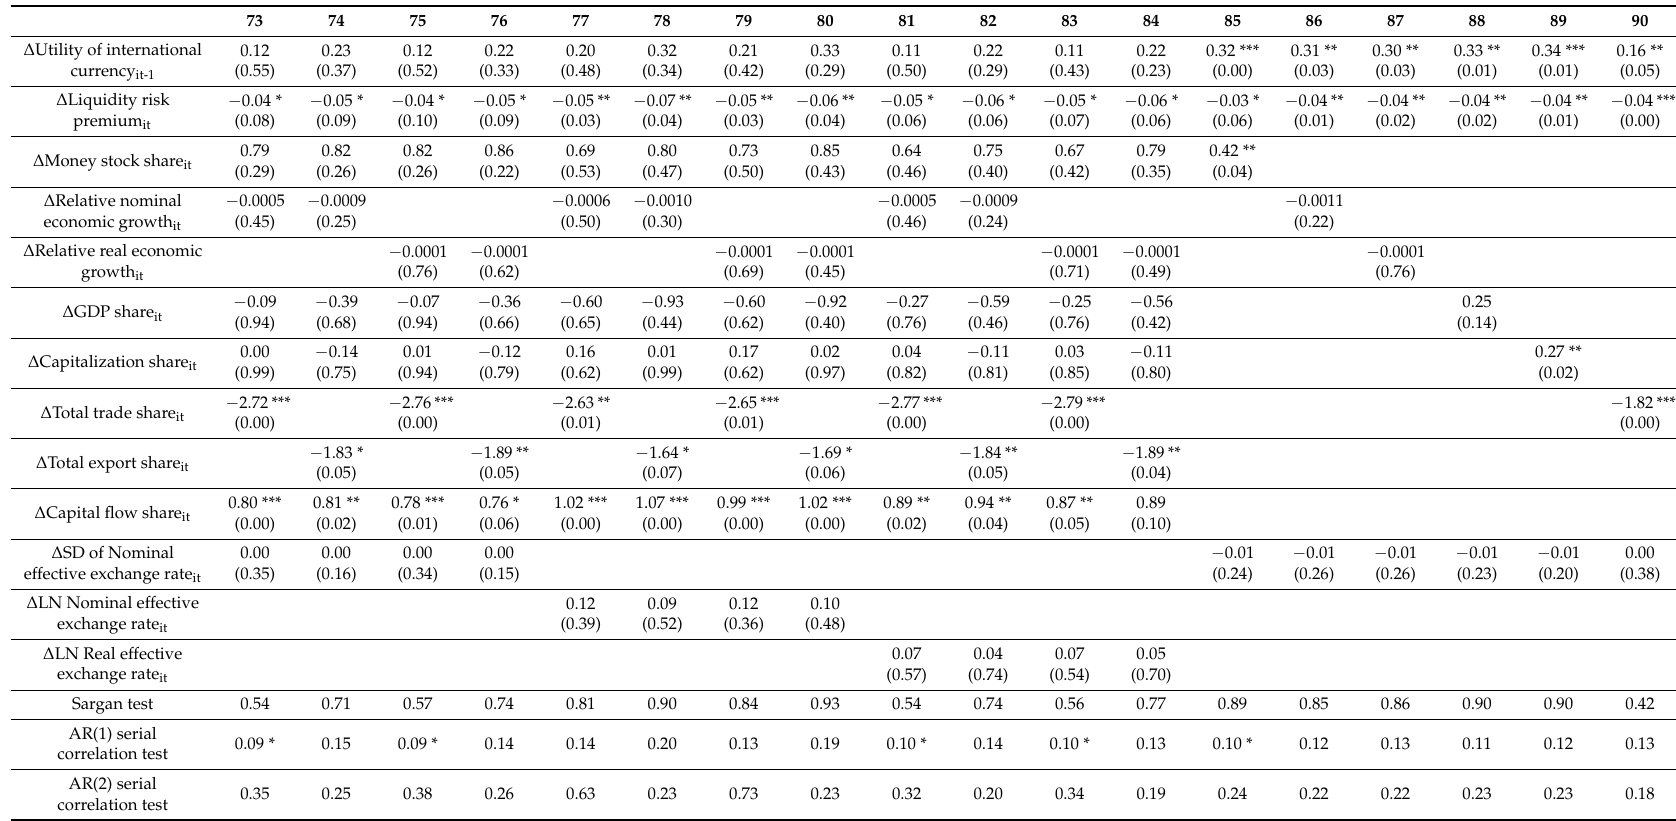
Table 4. Determinants utility of international currency (real interest rate